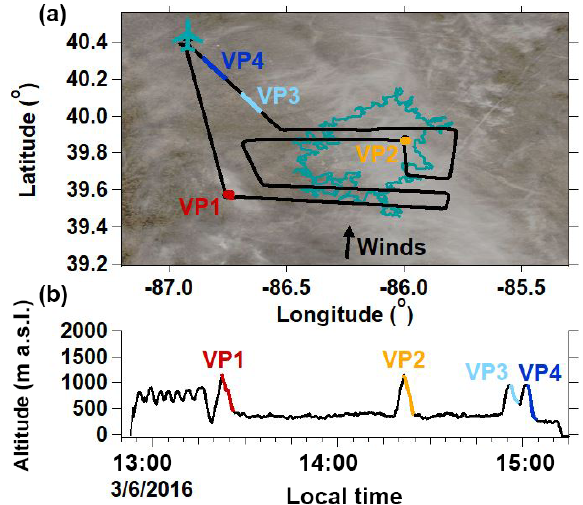
Figure 5. (a) CLR flight path overlaying the study site’s cloud cover (https://worldview.earthdata.nasa.gov/, last access: 5 Febru- ary 2018) captured at 12:30LT. The teal outline indicates the Indi- anapolis city boundaries. The West Lafayette, IN, Purdue airport is indicated by the airplane marker. (b) CLR case study altitude time series. Colored segments indicate vertical profile (VP)